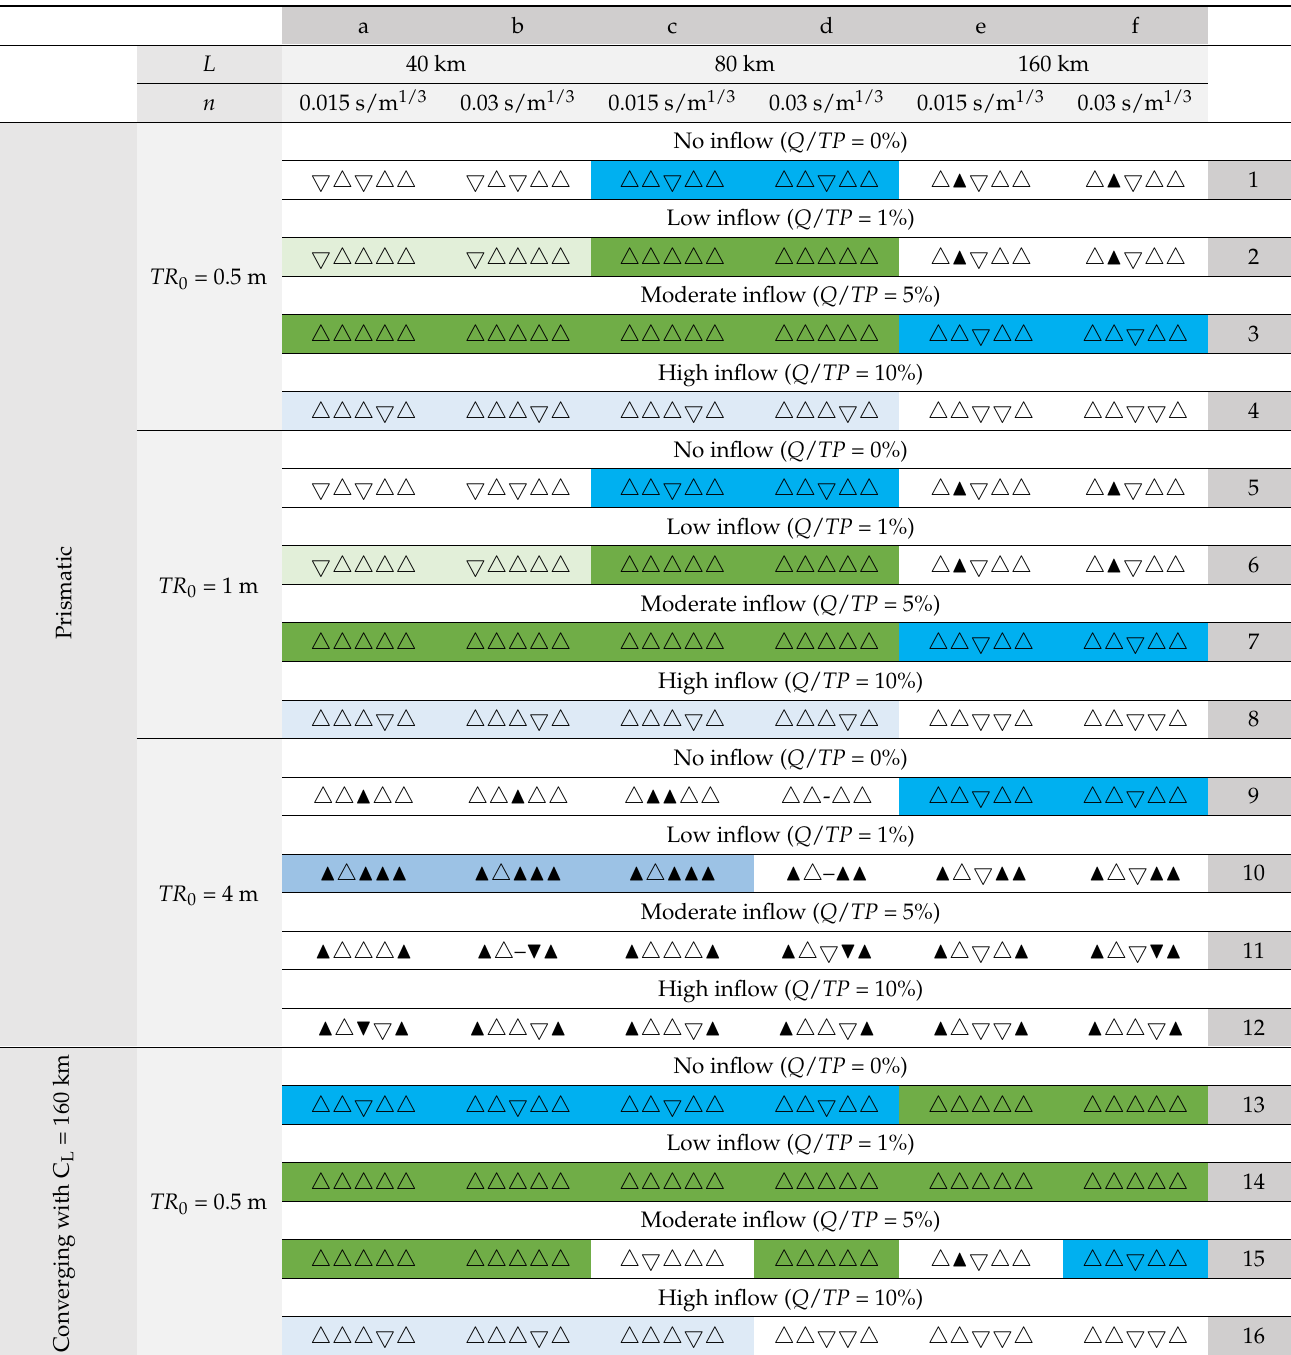
Table 3. Compounding effects of SLR and varying river inflows on transformed skewness at five nodes along the estuaries ( x = 0, 0.25 L , 0.5 L , 0.75 L , and L ), which are represented by five consecutive triangles in each cell. Upward and downward triangles indicate an increase or a decrease in trans- formed skewness induced by 1 m of SLR and for four varying river inflows ( Q / TP = 0%, 1%, 5%, and 10%). Hollow and solid triangles imply weak (0 ≤ | α | ≤ 0.5) and strong (0.5 < | α | ≤ 1) Pearson correlation coefficients, respectively. The symbol “–” denotes the absence of a correlation (for details, see [46]). Dominant patterns of change in tidal properties under compounding effects of SLR and river inflows are highlighted with similar colours across Tables